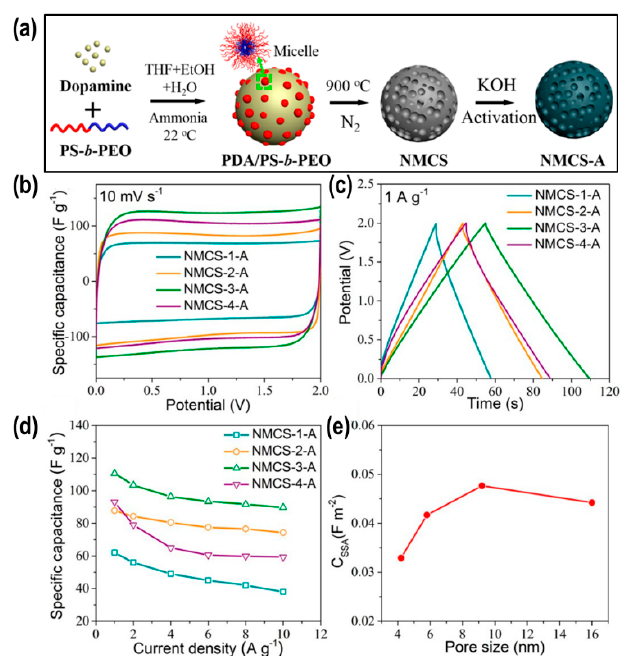
Figure 5. ( a ) Synthetic route to the fabrication of nitrogen-doped mesoporous carbon spheres (NMCS) followed by their activated products (NMCS − A) and electrochemical performances; ( b ) CV curves recorded at 10 mV s − 1 as typical example, ( c ) CD curves at 1 A g − 1 . ( d ) Calculated capacitance vs. current densities for different samples, and ( e ) Specific surface area normalized capacitance corresponding to 1 A g − 1 current density vs. pore size. Reproduced from Reference [133]. Copyright American Chemical Society, 2017.